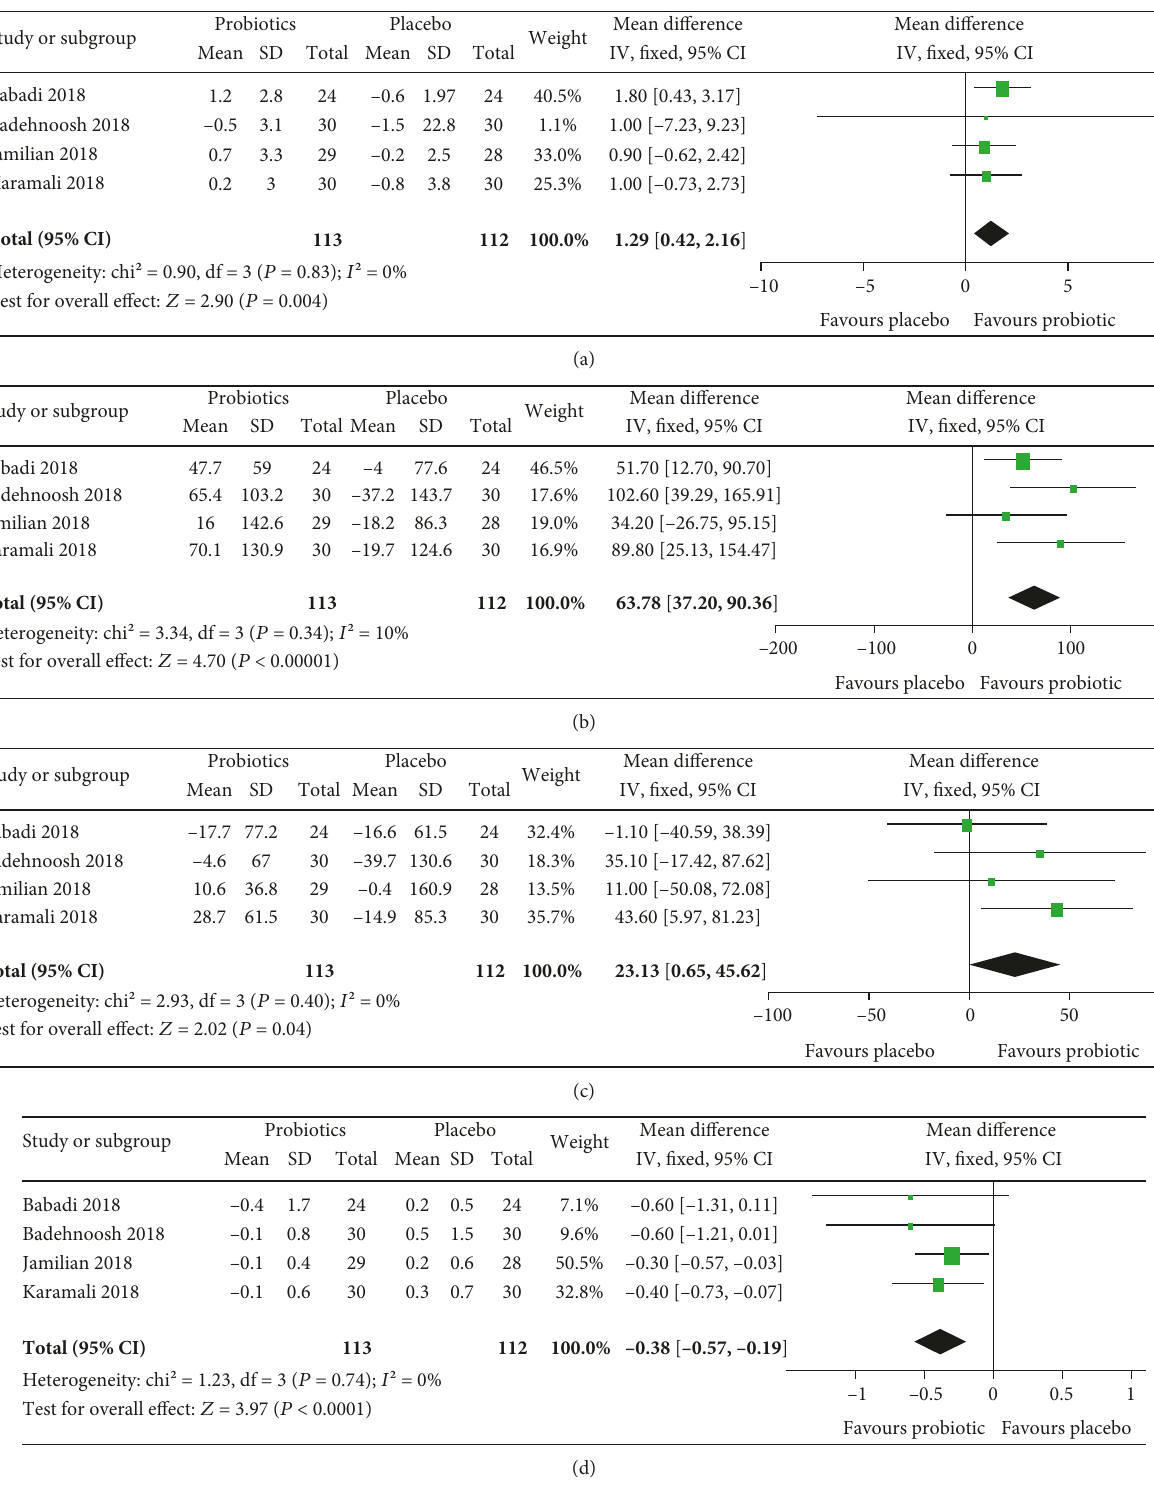
Figure 6: E ff ect of probiotic supplementation on biomarkers of in fl ammation and oxidative stress: (a) NO ( μ mol/L), (b) TAC (mmol/L), (c) GSH ( μ mol/L), and (d) MDA ( μ mol/L) in pregnant women with gestational